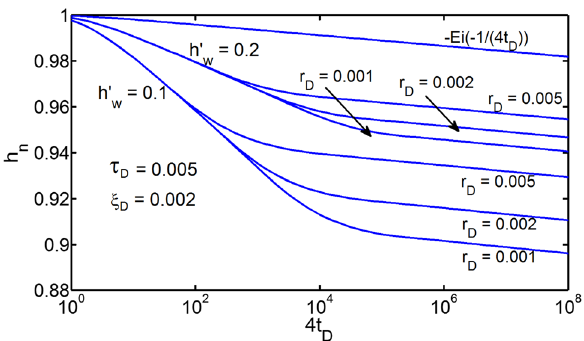
Fig. 5 Normalized thickness as a function of dimensionless time